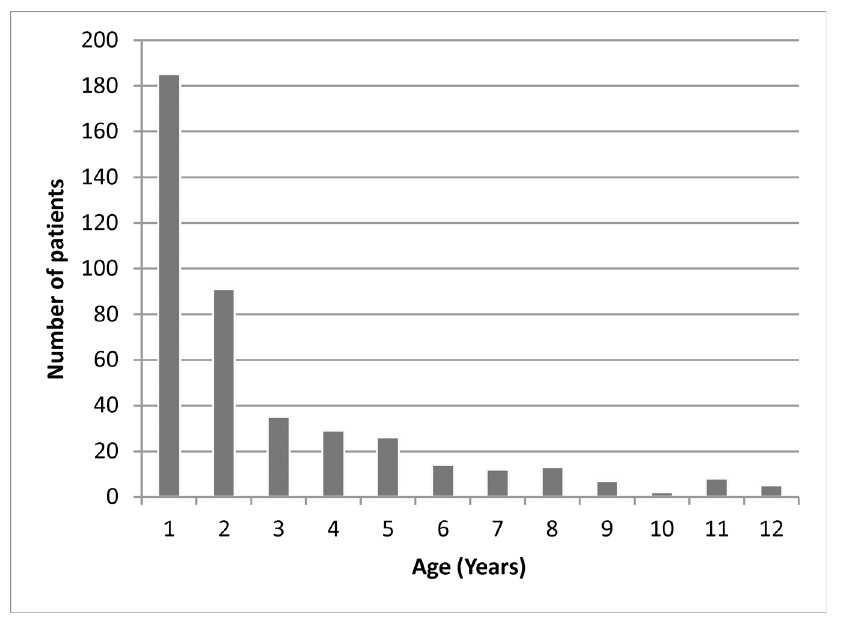
doi:10.1371/journal.pone.0147041.g001